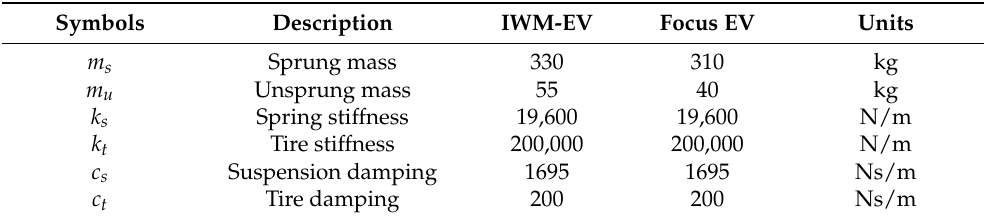
Table 1. System parameters.